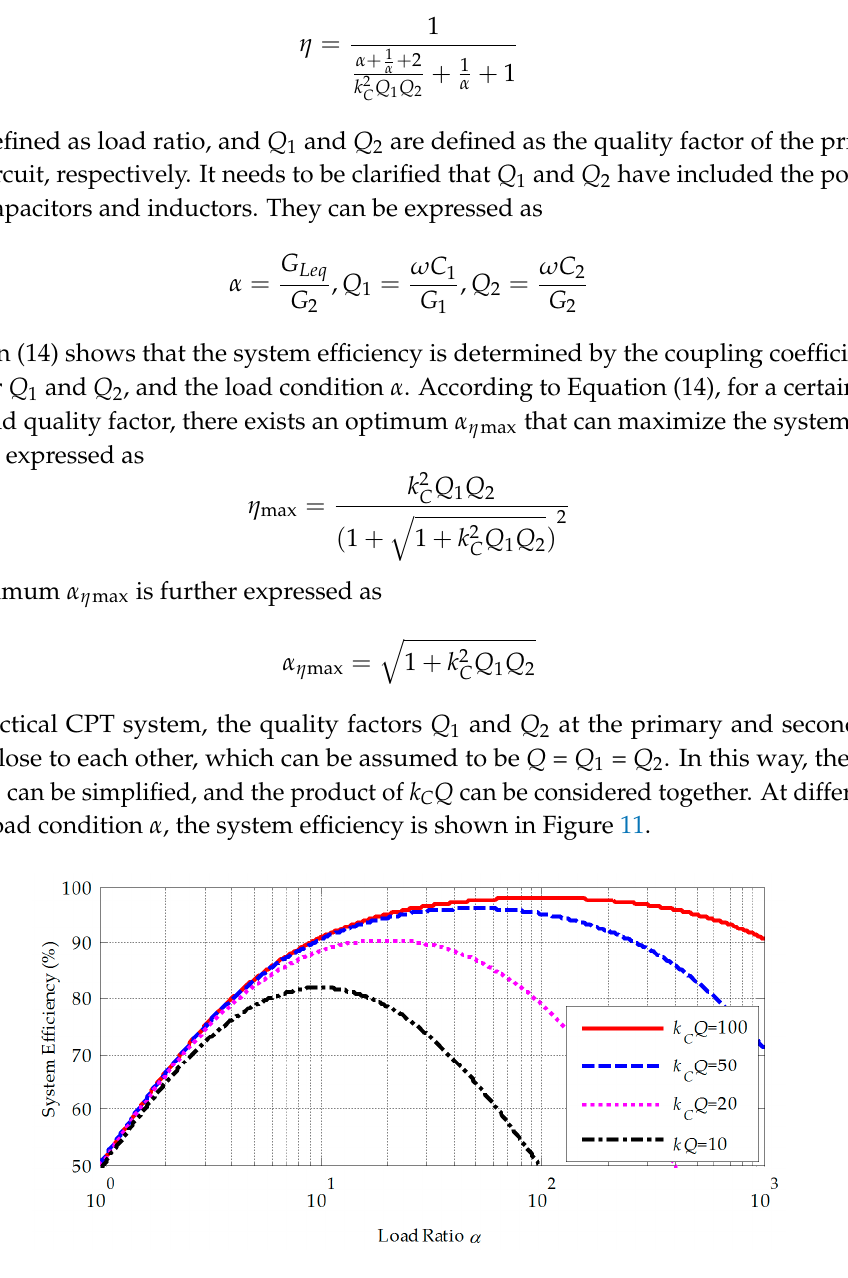
Figure 11. Efficiency of a CPT system at different values of k C Q and α .